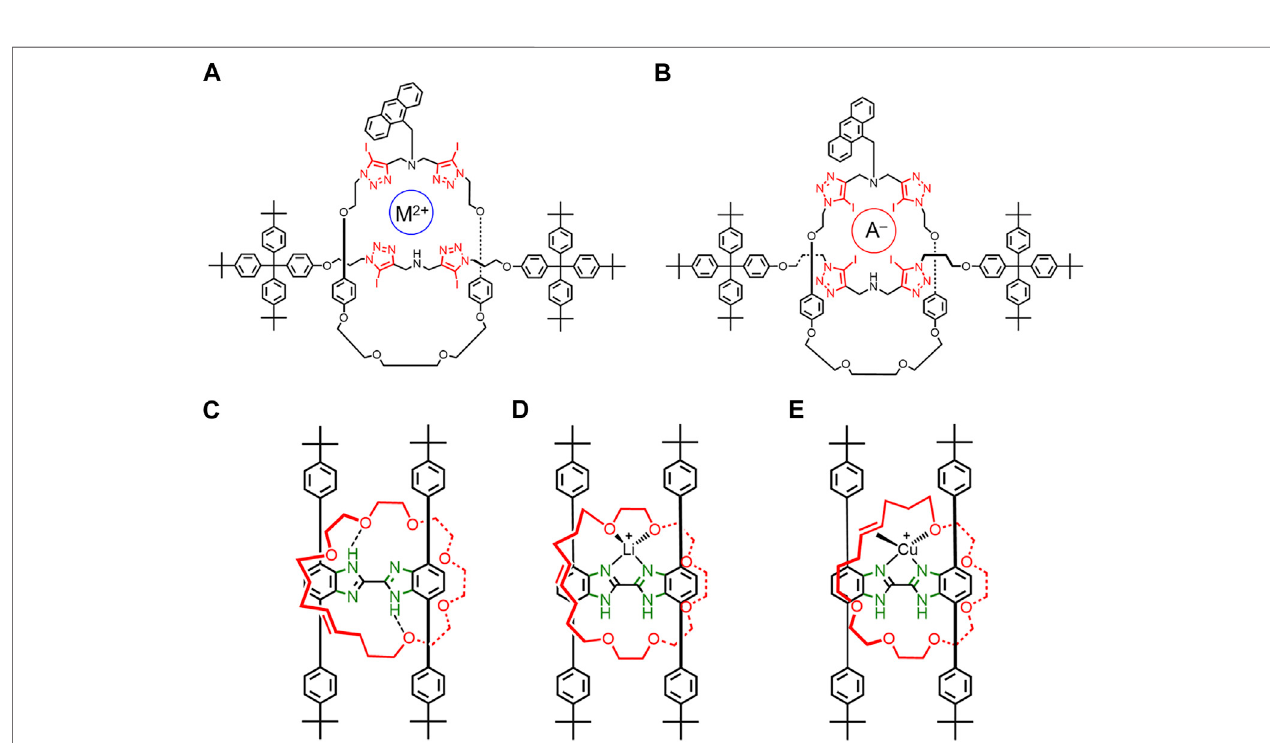
FIGURE 8 | A [2]rotaxane where (A) cation and (B) anion binding results in different iodotriazole conformations. Rotaxane rotational conformations with H-shaped thread and fl exible macrocycle when (C) no metal cation is present, (D) when Li + is present, and (E) when Cu + is present.